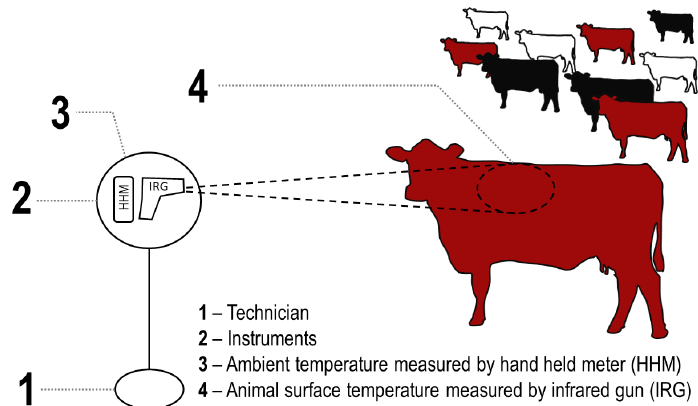
Figure 2. Field method for in situ measurement of ambient environmental temperature (Temp amb ) and cattle surface temperature (Temp cow ) using two separate thermal instruments simultaneously operated by a single technician. Temp amb measured with a handheld meter (HHM; Kestrel ® 3000). Temp cow measured with an infrared gun (IRG) high temperature thermometer (Extech Instruments ® 42,545 made by FLIR Systems ® ) with the laser placed approximately at the top of the shoulder from a distance of 5 to 15 m and sensed temperature was recorded. Temp amb and Temp cow were recorded simultaneously with HHM and IRG instruments in the same physical position. Cattle were white, red, and black Bos taurus cows free roaming on rangeland west of Laramie, WY, USA at the University of Wyoming, Agricultural Experiment Station, Laramie Research and Extension Center—Beef